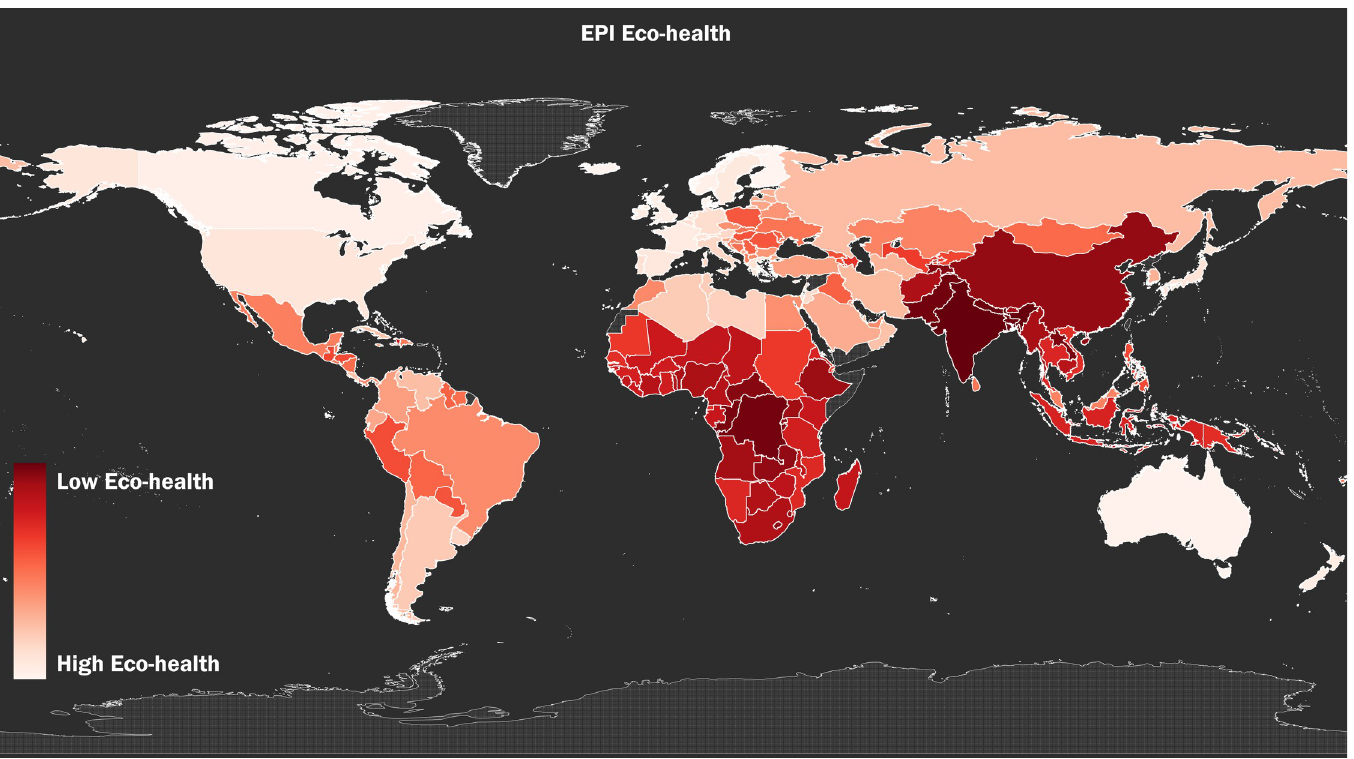
Fig 2. The global distribution of toxic pollution risk. The global distribution of toxic pollution risk using by-country rank-order, as measured by the variable Eco-health from the 2018 EPI [13].